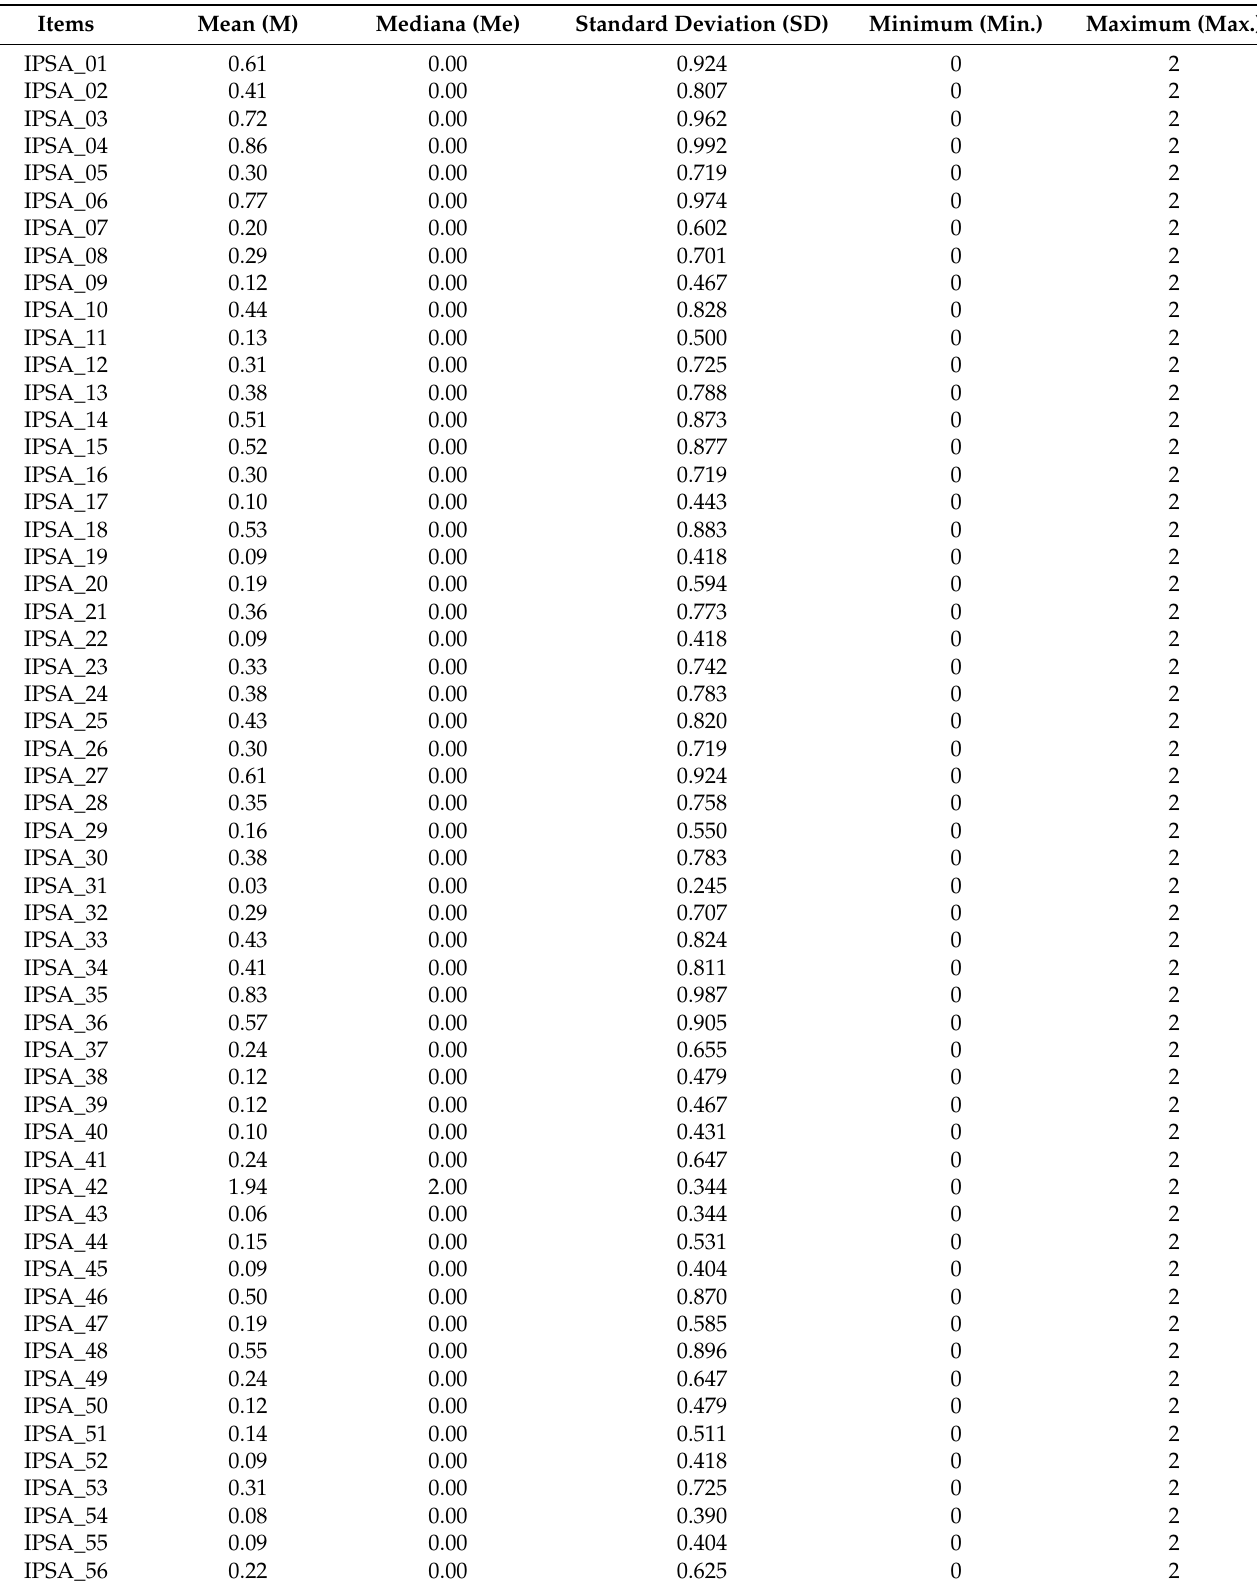
Table 4. Descriptive statistics for the Aggression Syndrome Psychological Inventory (IPSA II) scores of the participants ( n =